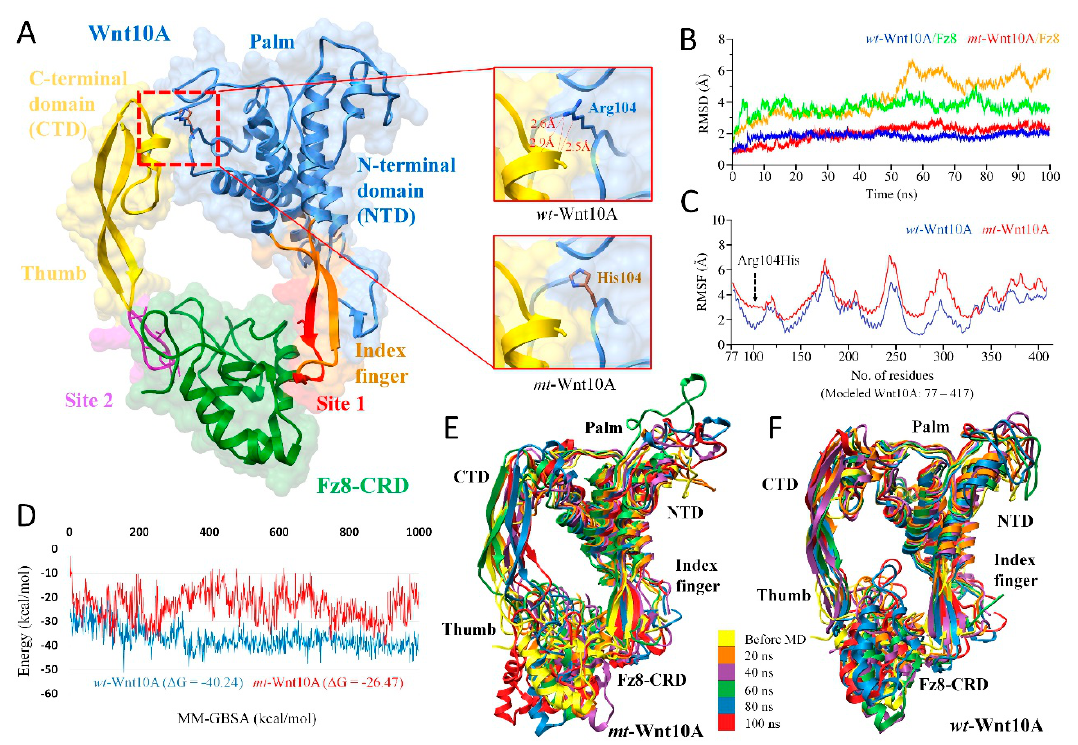
Figure 3. Structural analysis of WNT10A complexed with Fz8-CRD. (A) Overall structural representation of WNT10A in complex with Fz8-CRD followed by a close-up of interatomic interactions with a substitution of Arg104His in WNT10A . Ribbon representations of domains with distinct color as N-terminal index finger (brown), central palm (cauliflower) and C-terminal thumb (gold) domains, while Fz8-CRD is displayed in green. (B) RMSD trajectories of WNT10A C α -backbone atoms of mutant (red) and wild-type (blue) complexed with Fz8-CRD throughout 100ns. (C) RMSF trajectories of mutant (red) and wild-type (blue). (D) MM-GBSA trajectories (total of 1000 snapshots from the 100ns MD simulations) of mutant (red) and wild-type (blue) (E and F) . Structural conformations of WNT10A/Fz8-CRD obtained after 20ns, 40ns, 60ns, 80ns, and 100ns are superimposed together.